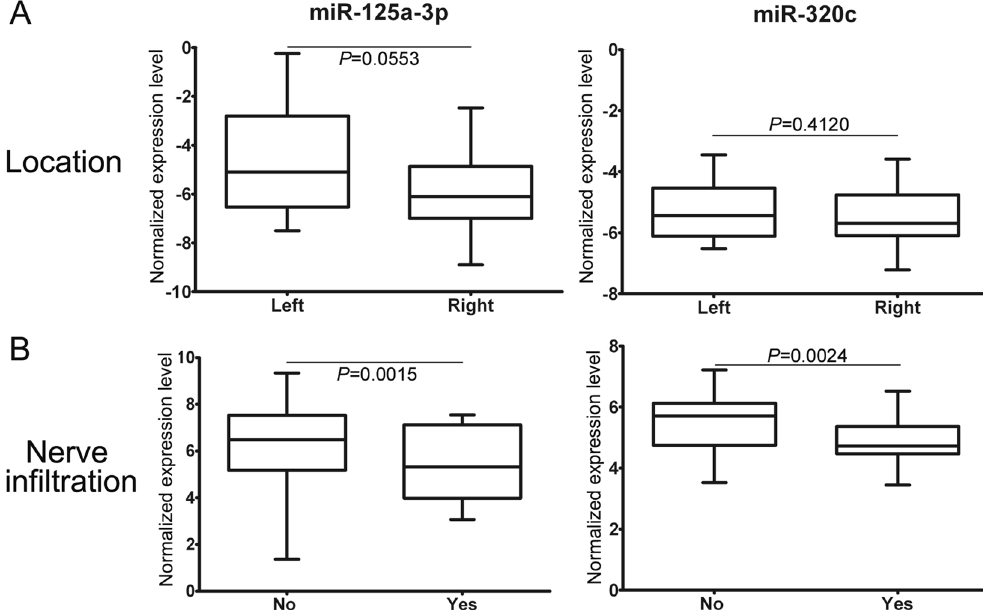
Figure 4. Relationship between the tumor markers and the clinical characteristics. Shown are statistically analysis on trend between miR-125a-3p versus tumor location and nerve infiltration ( A ), and miR-320c versus tumor location and nerve infiltration ( B ). Boxes show the range from first to third quartiles and are divided by the line of median (second quartile). The plus and minus whiskers indicate the maximum and minimum,